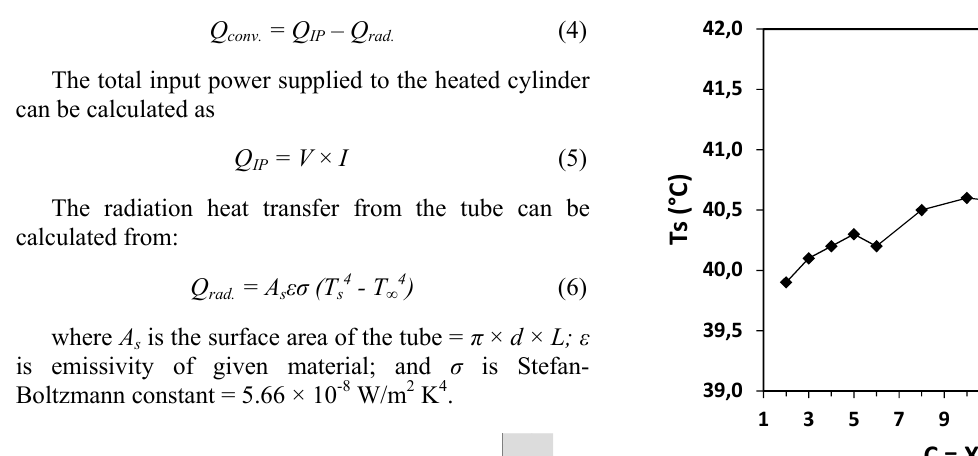
Fig 4. Surface temperature for q = 159 W/m 2